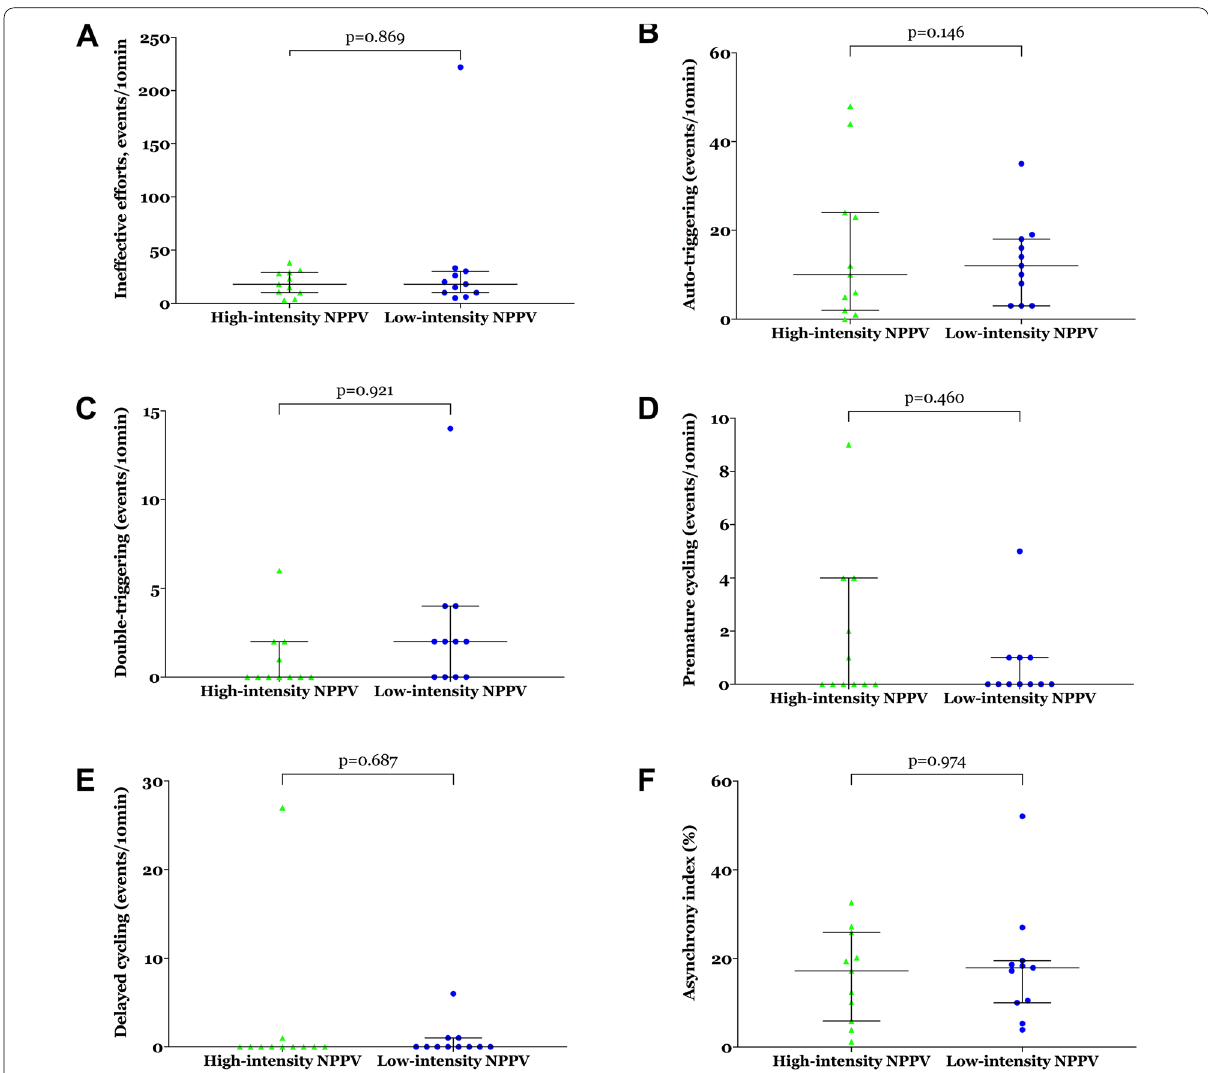
Fig. 5 a Ineffective efforts, b auto-triggering, c double-triggering, d premature cycling, e delayed cycling, and f the asynchrony index within 24 h after randomisation. Values are individuals, medians, and interquartile ranges. NPPV noninvasive positive pressure